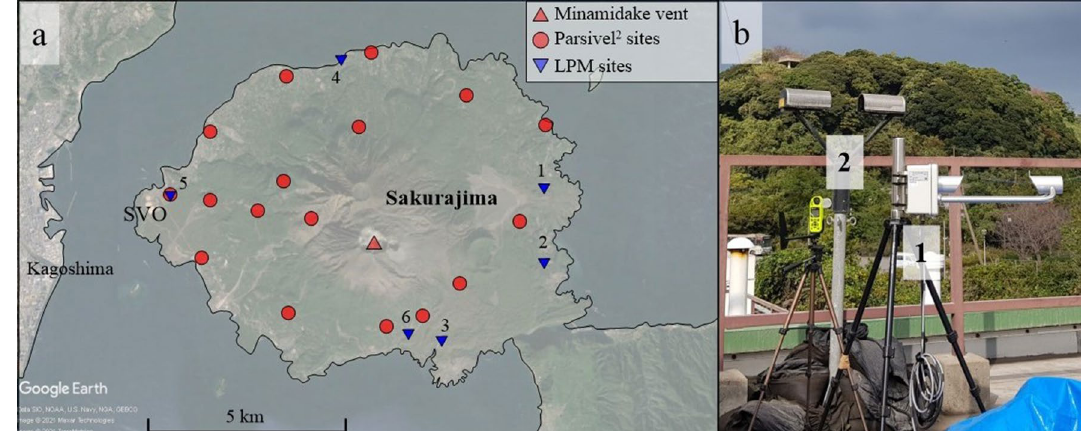
Figure 1. ( a ) Map of Sakurajima Volcano and disdrometer sampling sites (blue triangles: LPM sites; red dots: PS2 sites). SVO indicate the monitoring station from which PS2 data have been compared with LPM records. Numbers indicate the index of each site reported in Table 1. Map generated from Google Earth Pro 7.3.4.8248 available in https:// www. google. fr/ earth/ downl oad/ gep/ agree. html. ( b ) Picture of the LPM (1) next to the